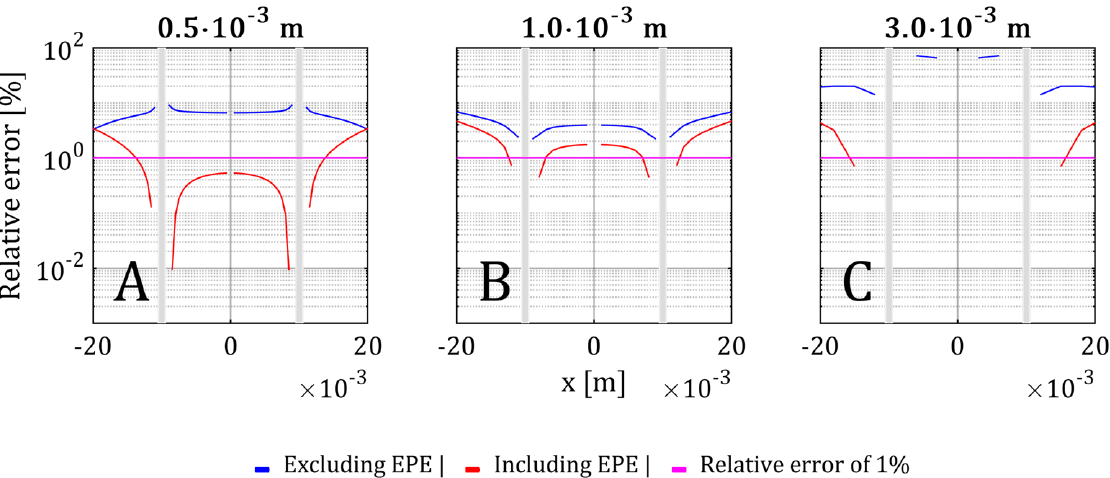
Figure 10. Relative error of electric-potential distributions of the cylindrical electrode pair model (central grid) with respect to the analytical solution along the x-axis for the voxel sizes ( A ) 0.5 × 10 − 3 m, ( B ) 1.0 × 10 − 3 m, and ( C ) 3.0 × 10 − 3 m. The grey bars represent the electrodes of the cylindrical electrode pair. The discontinuity in the blue and red lines reflects the local relative error approaching 0%.